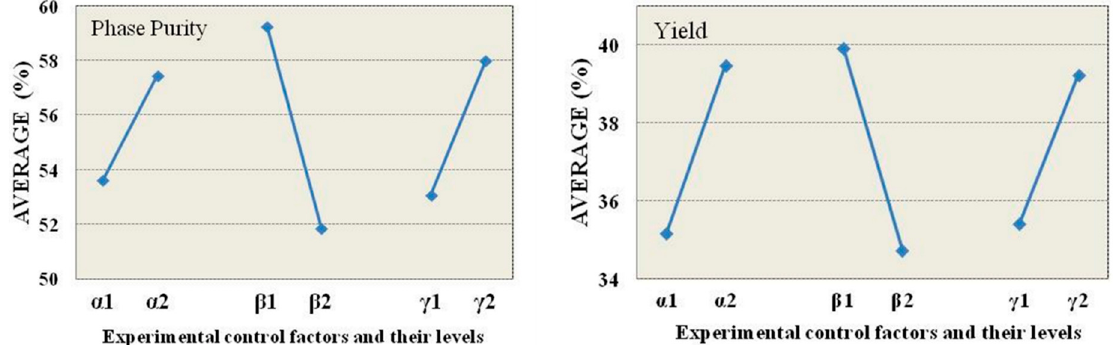
Figure 3. The factor response graphs for the average phase purity ( left ) and yield ( right ) of smectite synthesis.